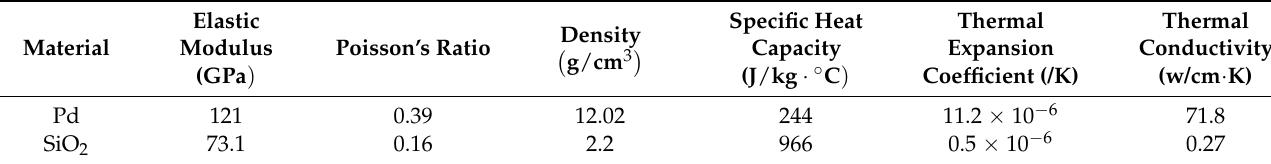
Figure 1. Simplified diagram of the sensor model. Table 1. Material parameters.